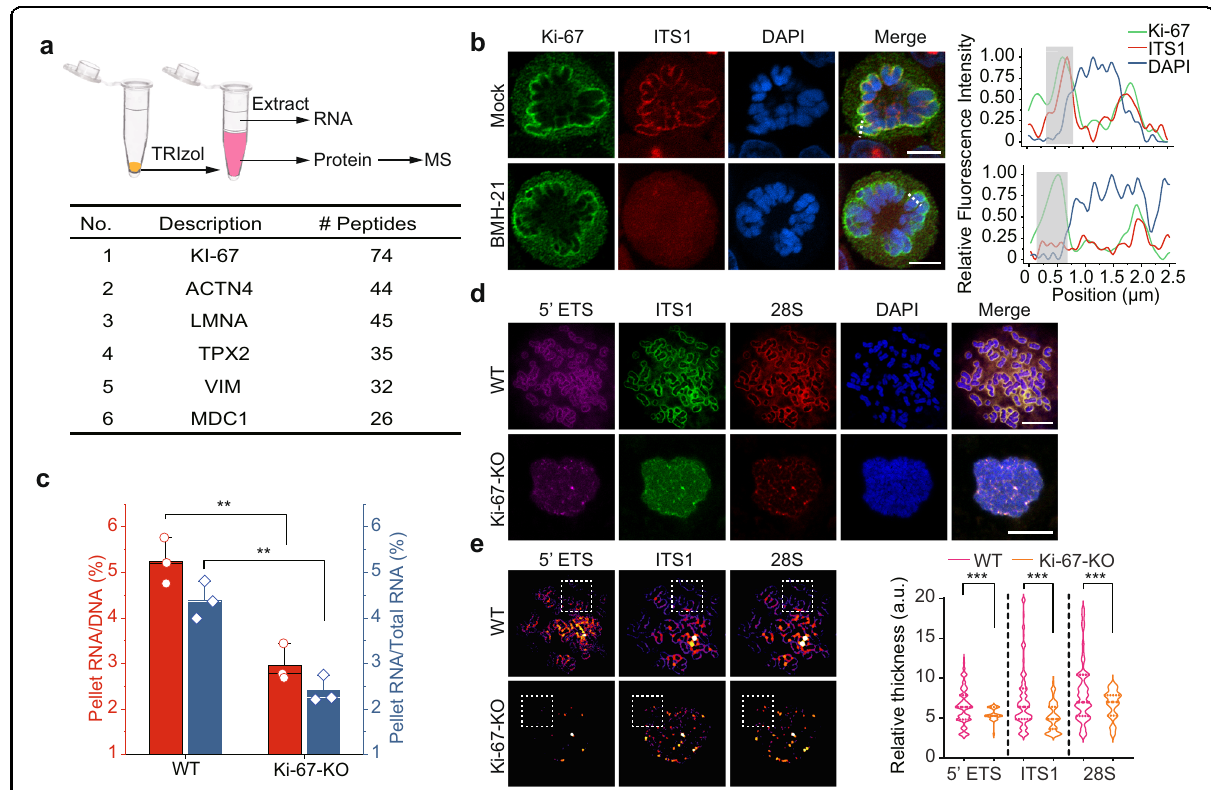
Fig. 4 Ki-67 mediates pre-rRNA ’ s association with chromosomes. a The protein species in the pellet fraction. The protein species was isolated from TRIzol extraction and analyzed by mass spectrometry. The top six abundant proteins are shown. b The localization of Ki-67 and pre-rRNA at the periphery of chromosomes. Pre-rRNA was examined by RNA FISH with probes against the ITS1 region in mitotic cells treated with or without BMH-21. Ki-67 was examined with anti-Ki-67 antibody. Signal intensity of pre-rRNA, Ki-67, and DAPI at the indicated section was analyzed (right panel). Scale bar, 5 μ m. c The ratio of RNA in the pellets to total DNA mass (left y axis) and the ratio of RNA in the pellets to total RNA (right y axis) in parental 293T and Ki-67 knockout cells. ** P < 0.01. d Localization of pre-rRNAs detected by RNA FISH with Cy5-labeled probe against 5 ’ ETS, FAM-labeled probes against ITS1 and Cy3-labeled probe against 28S region of pre-rRNAs at the perichromosomal layer in parental 293T and Ki-67-knockout cells. Scale bar, 10 μ m. e The RNA FISH signals were analyzed by “ Local Thickness ” of Fiji, the dashed square shows the region of interest. *** P <